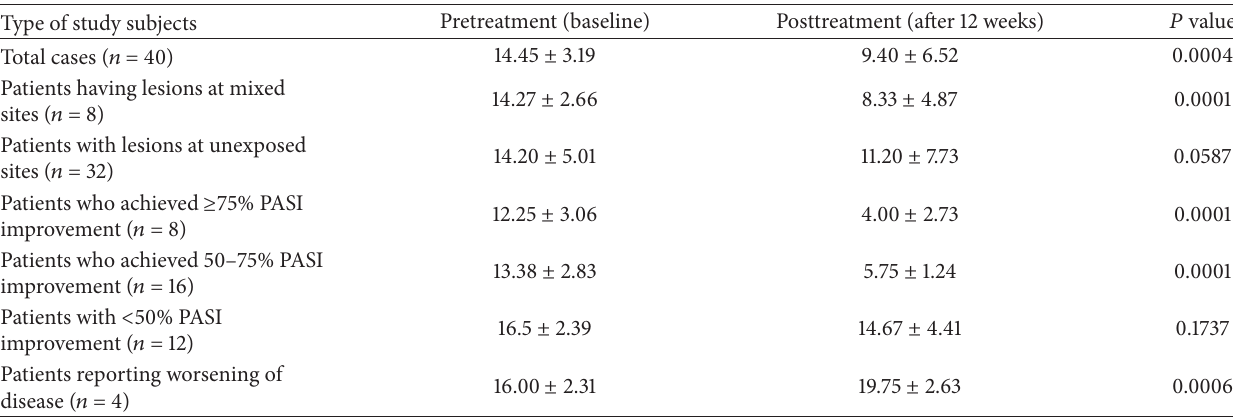
Table 3: DLQI scores in study group at baseline and after 12 weeks of regular